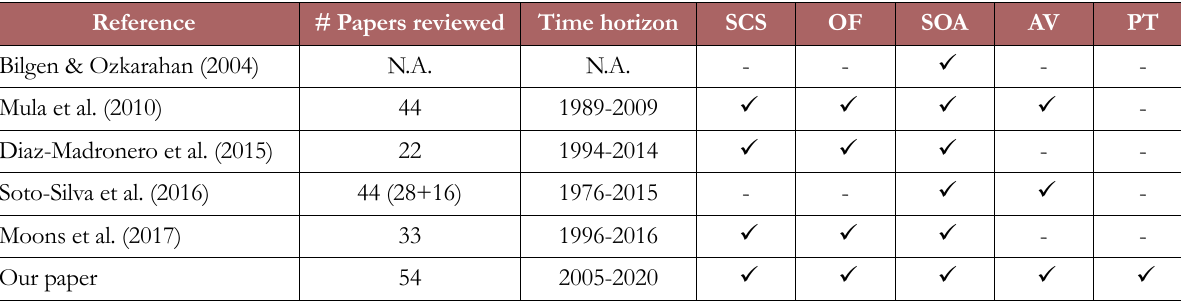
Table 1. Comparison between our paper and the other literature